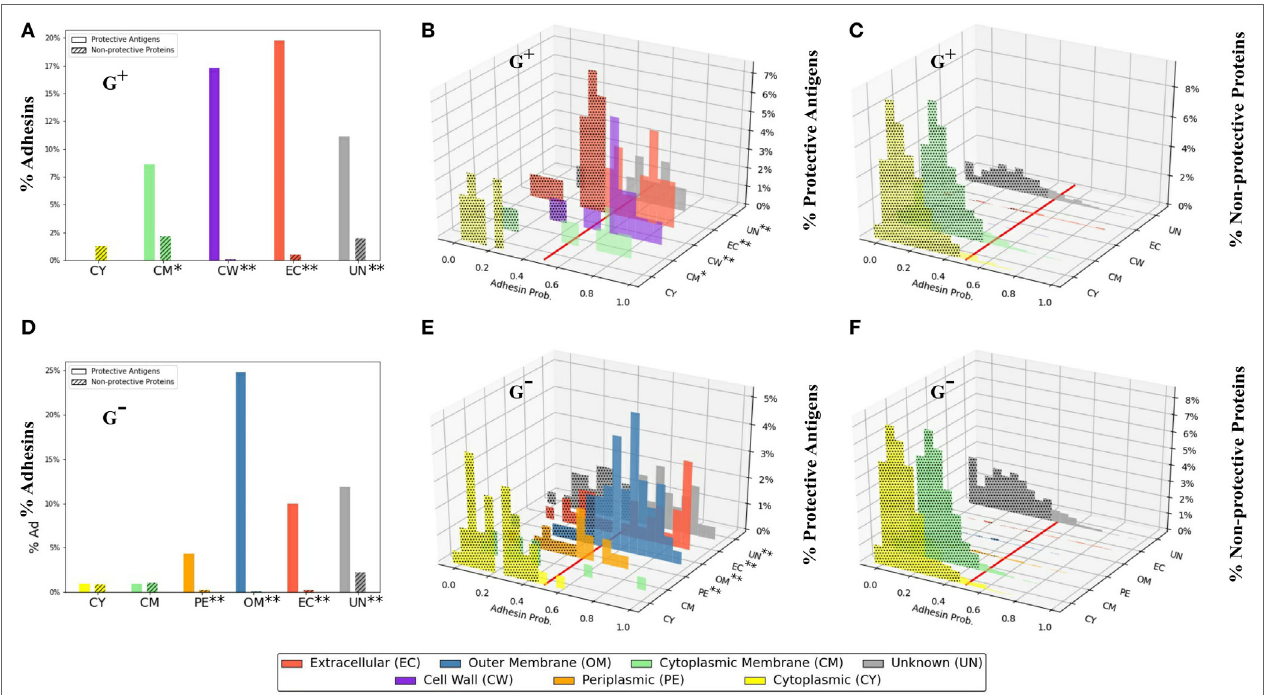
FigUre 2 | Profiles of adhesin probabilities of protective antigens (PAgs) and non-protective proteins with different subcellular localizations. The top three panels (a–c) show G + pathogens, and the bottom three panels show G − pathogens. Specifically, the first column (a,D) represents the overall percentages of adhesin probabilities. The second column ( B,e ) and third column (c,F) show adhesin probability distributions of PAg and non-protective proteins, respectively. The red line in (B,c,e,F) indicates adhesin probability cutoff of no < 0.51. Overall, PAgs have significantly higher ( p < 0.01) percentages in EC (G + and G − ), CW (G + ), and PE and OM (G − ) (abbreviations shown in bottom color key legend). Interestingly, CM in G + is also significant ( p < 0.05) when coupled with adhesin probability. See the text for detailed discussion. The significant over-representation of PAgs’ adhesin probabilities at different subcellular localizations compared with non-protective proteins is indicated with “*” ( p < 0.05) or “**” ( p <